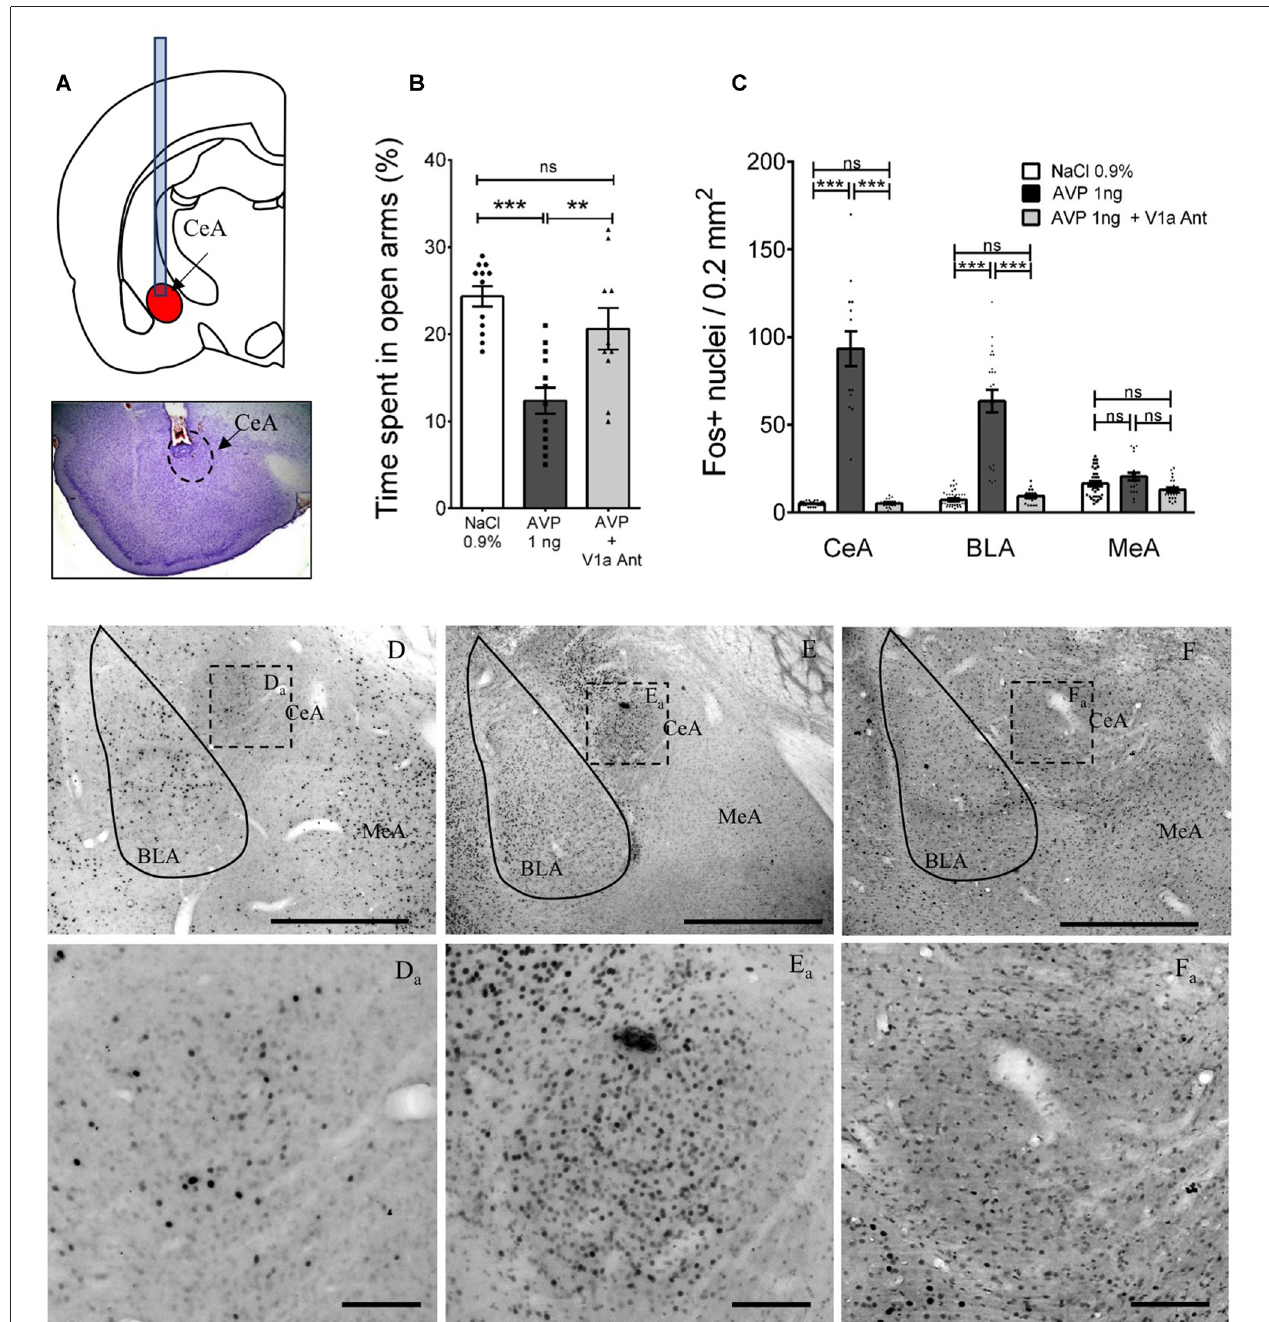
FIGURE 9 | Altered anxious behavior and Fos expression after AVP infusion into CeA in AFR rats and reversal by co-infusion of V1a antagonist (Manning compound). (A) Upper panel depicts positioning of cannulae in CeA for infusion of vehicle, AVP, or AVP plus V1a antagonist (Manning compound); lower panel is a representative photomicrograph showing the trajectory of the cannula toward the CeA. (B) Bar graph showing the time spent in the open arms of the EPM in animals infused bilaterally with vehicle (NaCl 0.9%), AVP or AVP + V1a antagonist (Manning compound). Infusion of AVP into CeA produced anxiety-like behavior shown as a reduction of the time spent in the open arms ( ∗∗ p < 0.01, ∗∗∗ p < 0.001) compared with vehicle-treated rats. Infusion of AVP + V1a antagonist reversed anxious behavior (decreased time spent in open arms) to control levels (i.e., indistinguishable from vehicle-treated rats). (C) Bar graph showing the quantification of neurons activated (measured by Fos expression) after EPM in the CeA, BLA and MeA in vehicle, AVP, or AVP plus V1a antagonist infused groups. AVP produced a significant increase in the Fos expression in the central (CeA, p < 0.001) and basolateral nuclei (BLA, p < 0.001) that was blunted in the AVP + V1a antagonist group. No effect of the treatments was observed in the MeA. (D–F) Photomicrographs showing the Fos expression patterns seen in the three infusion groups after the EPM, (D a –F a ) are magnifications of the squared regions in (D–F) . BLA, basolateral amygdala; CeA, central amygdala; MeA, medial amygdala. Scale Bars: (D–F) 1 mm; (D a –F a ) 0.1